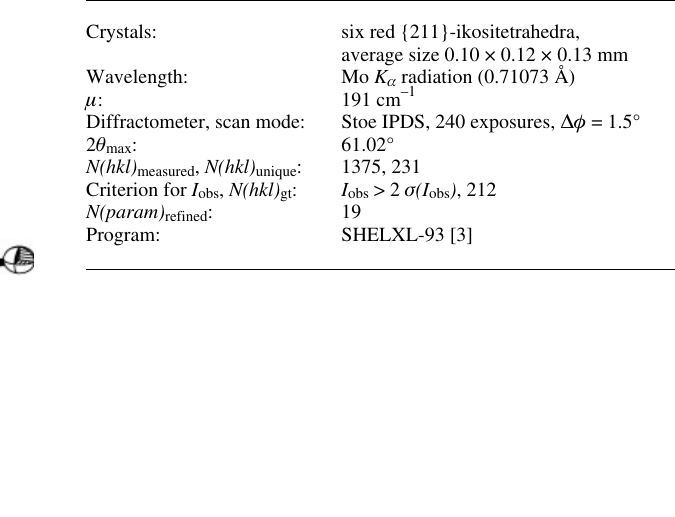
Table 1. Data collection and handling.